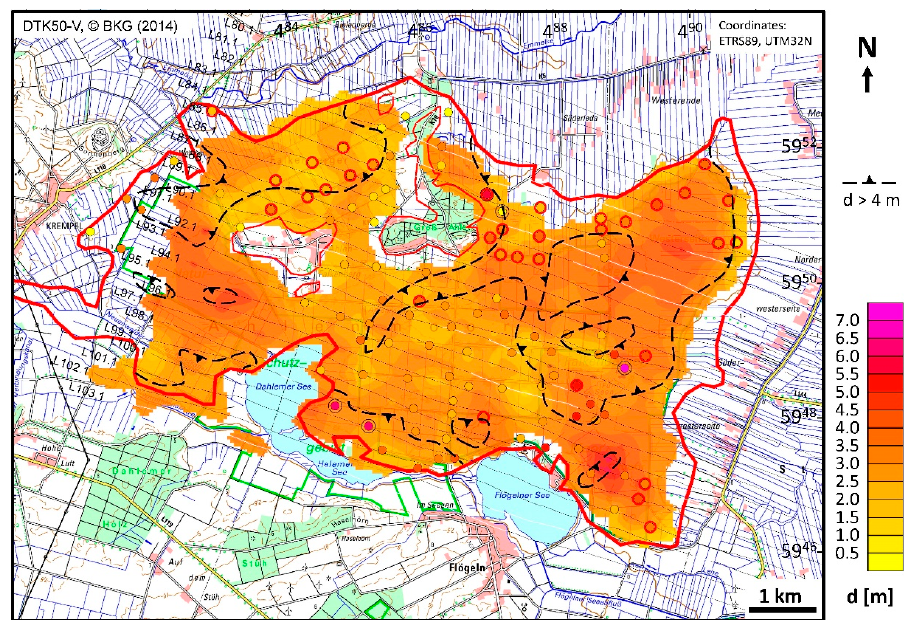
Figure 18. Peat thickness derived from HEM and HRD data (grid) in comparison with peat thickness found in boreholes (dots [20] and dashed lines [15]). Black/red circles indicate greater differences (above ±2 m)/clayey sediments below the peat, respectively. The black lines are the flight lines, which are colored white at places where HEM data values were interpolated at the highest frequency. Remote Sens. 2020 , 12 , x FOR PEER REVIEW The differences in the airborne mapping and the borehole results (Figure 19) were small on average. The mean differences were Δ m = 0.0 ± 1.1 m (thickness) and Δ m = − 0.1 ± 1.1 m amsl (peat base elevation), but locally a few greater differences above ±2 m (dotted lines in the scatter plot) did occur.